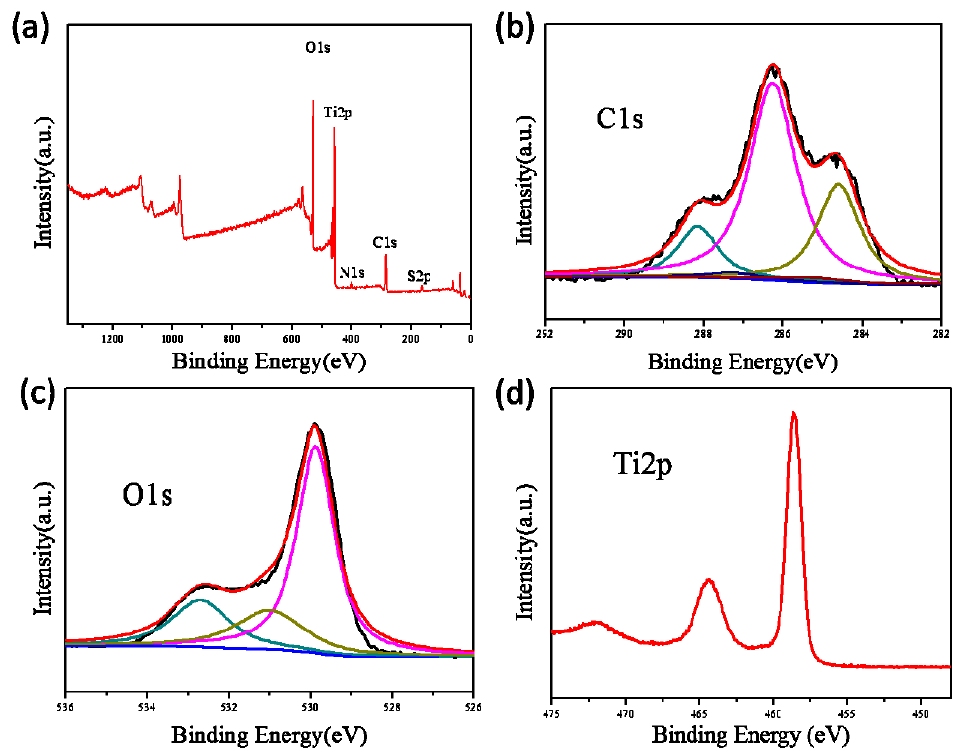
Figure 7. ( a ) Survey XPS spectra of TiO 2 @CNF Aerogel, ( b ) C 1s, ( c ) O 1s, and ( d ) Ti 2p XPS spectra of TiO 2 @CNF Aerogels, respectively.